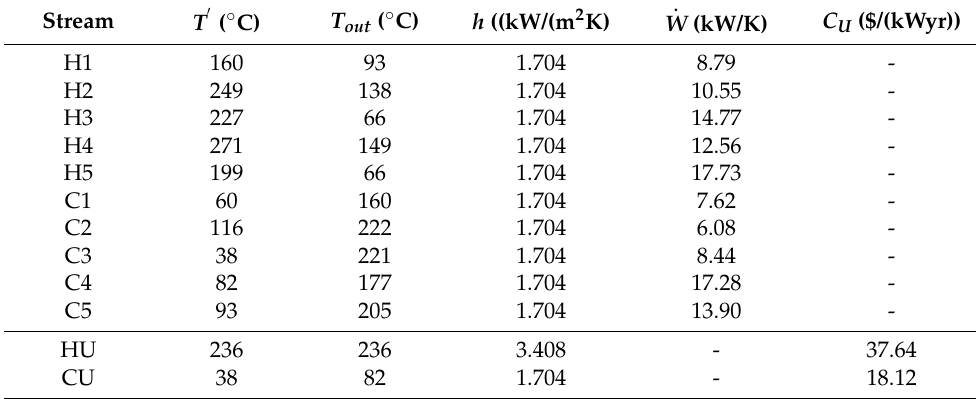
Table 1. Problem data for example